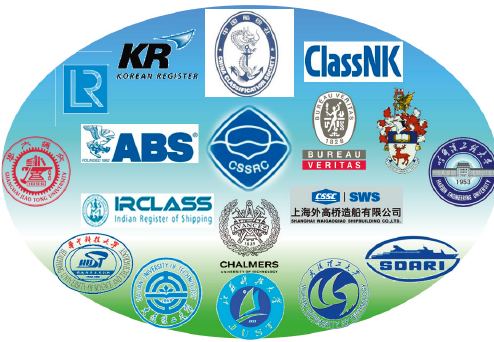
Figure 1: Initiators and members of CSSRC-20,000 TEU